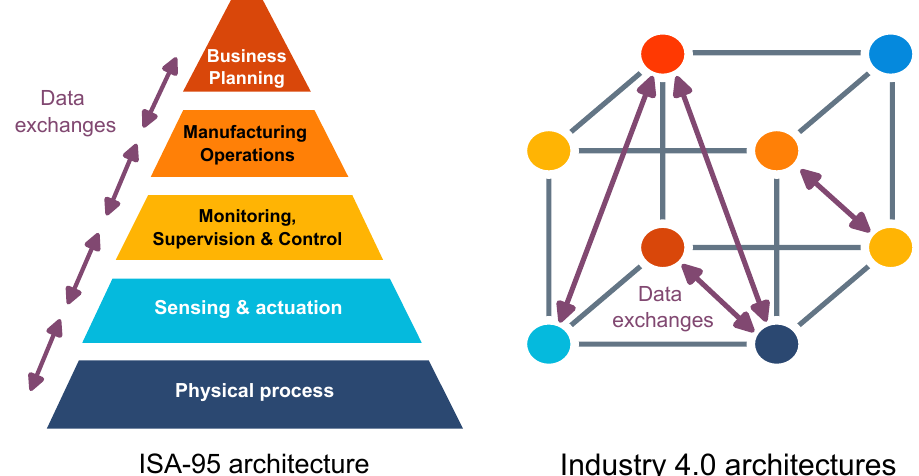
Figure 1. Hierarchical vs. meshed communication models in ISA-95 vs. Industry4.0